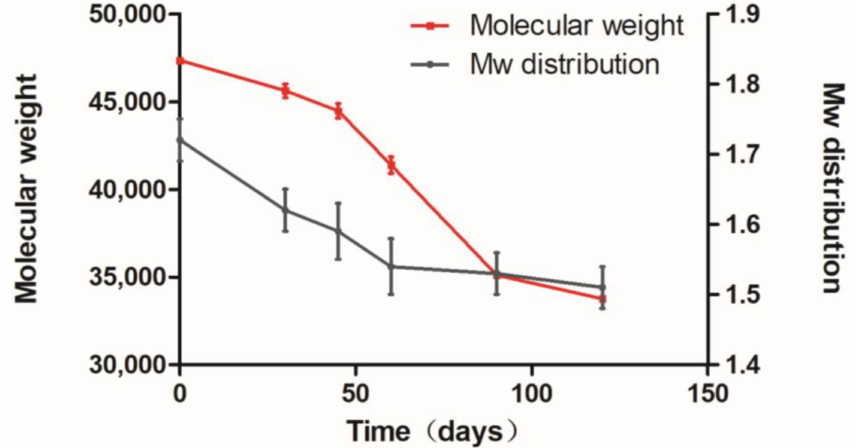
Figure 7. Degradation of polylactic acid in implants In Vivo.